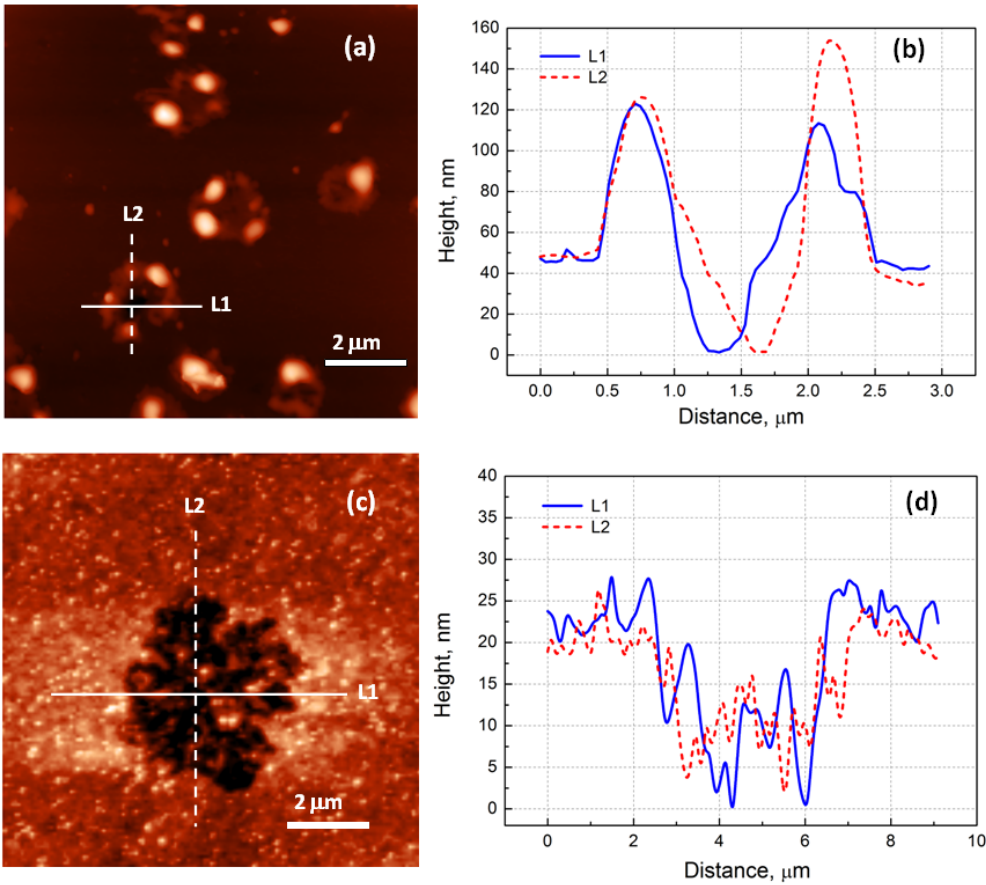
Figure 4. AFM data obtained after a 1 min electron irradiation: ( a )—29 nm thick film; ( c )—53 nm thick film. Profiles of surface relief along L1 and L2 directions: ( b )—29 nm thick film; ( d )—53 nm thick film.